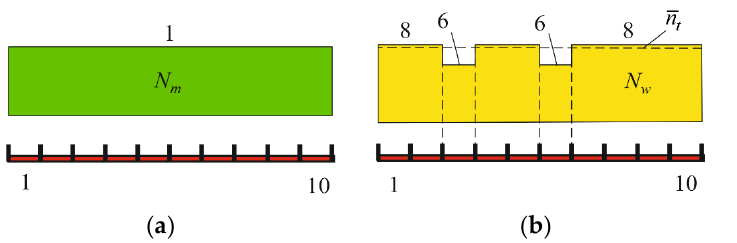
Figure 7. Distribution of resources in time: schedule of machine operations ( a ), schedule of work performance by the core construction workers ( b ).